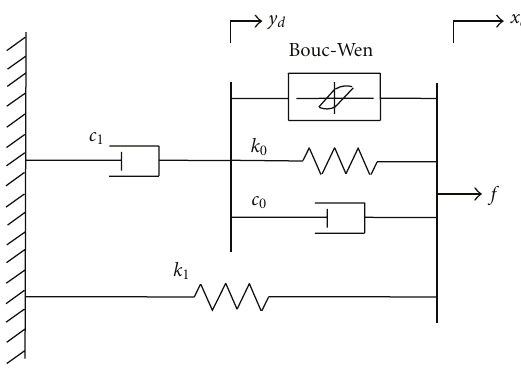
Figure 1: Mechanical model of the MR damper (Modified Bouc- Wen model)